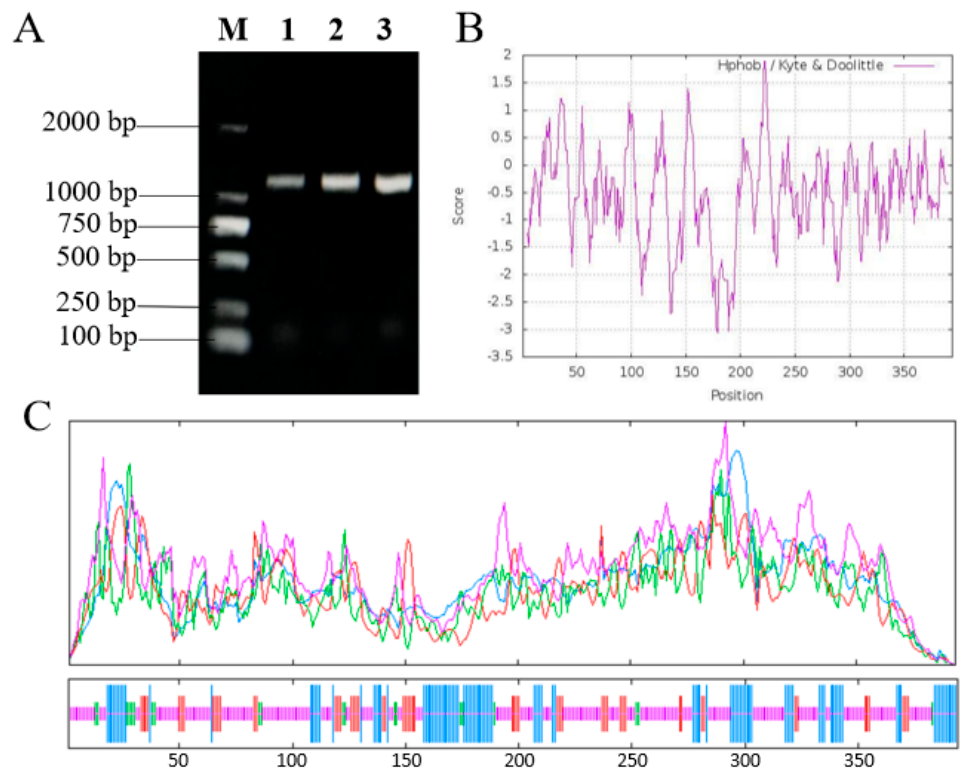
Figure 1. Sequence cloning and analysis of OfSPL11 . ( A ) CDS cloning of the OfSPL11 ; ( B ) hydrophilicity and hydrophobicity of the OfSPL11 ; ( C ) protein secondary structure of OfSPL11 . Blue line indicates α− helix, red line indicates extended chain, green line indicates β− turn, and purple line indicates irregular coil.